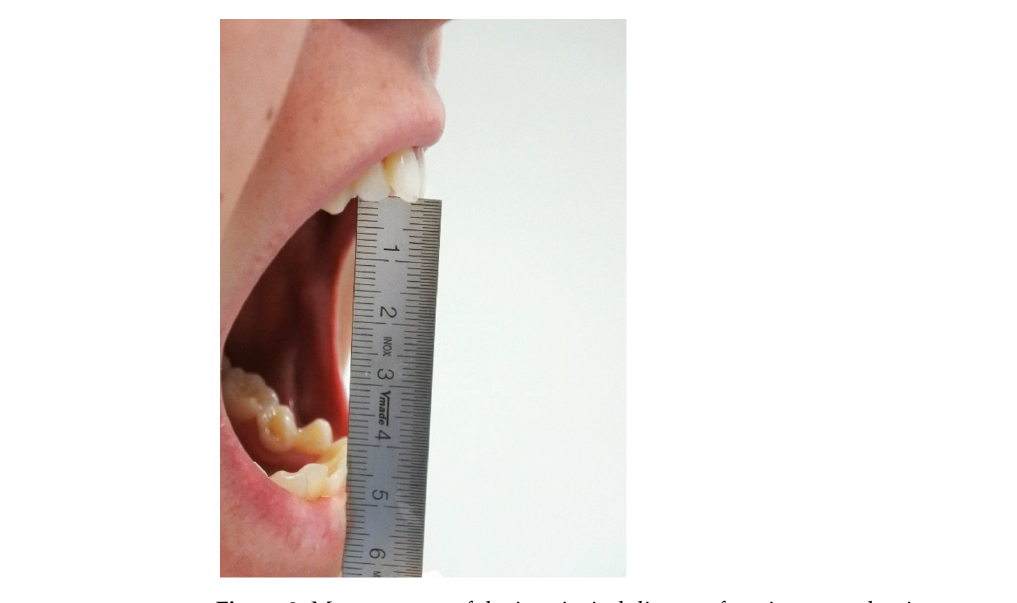
Figure 2. Measurement of the interincisal distance for trismus evaluation.